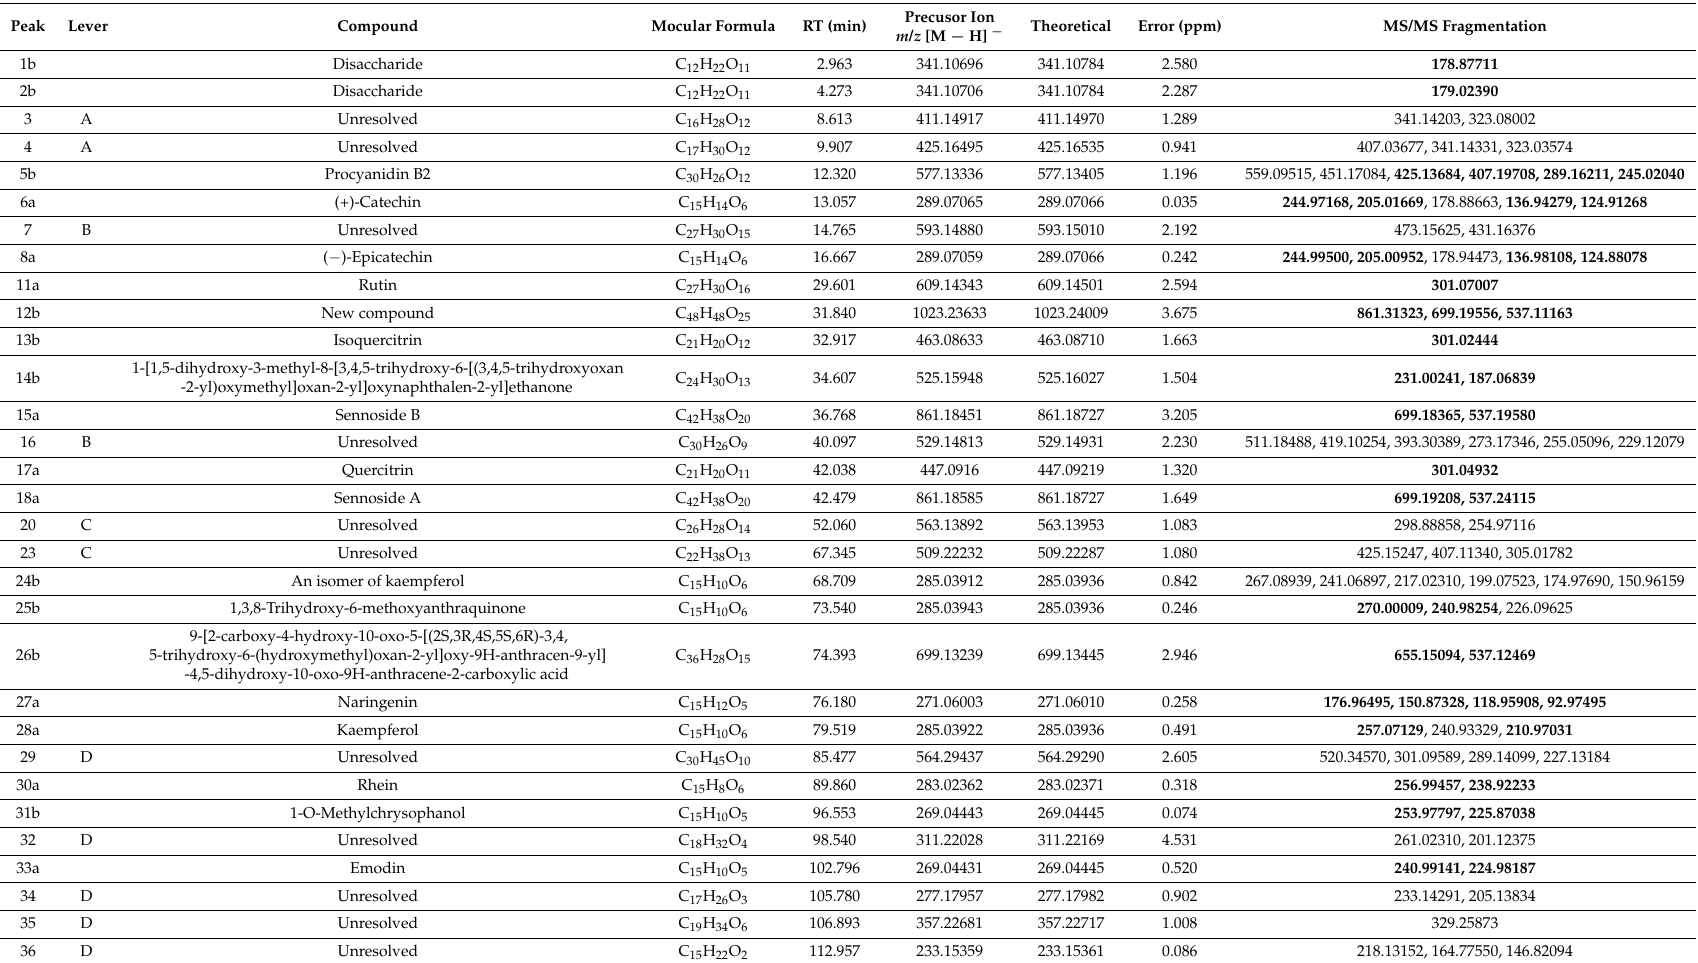
Table 3. Compounds identified in the fruit of C. fistula by UHPLC/LTQ-Orbitrap MS n